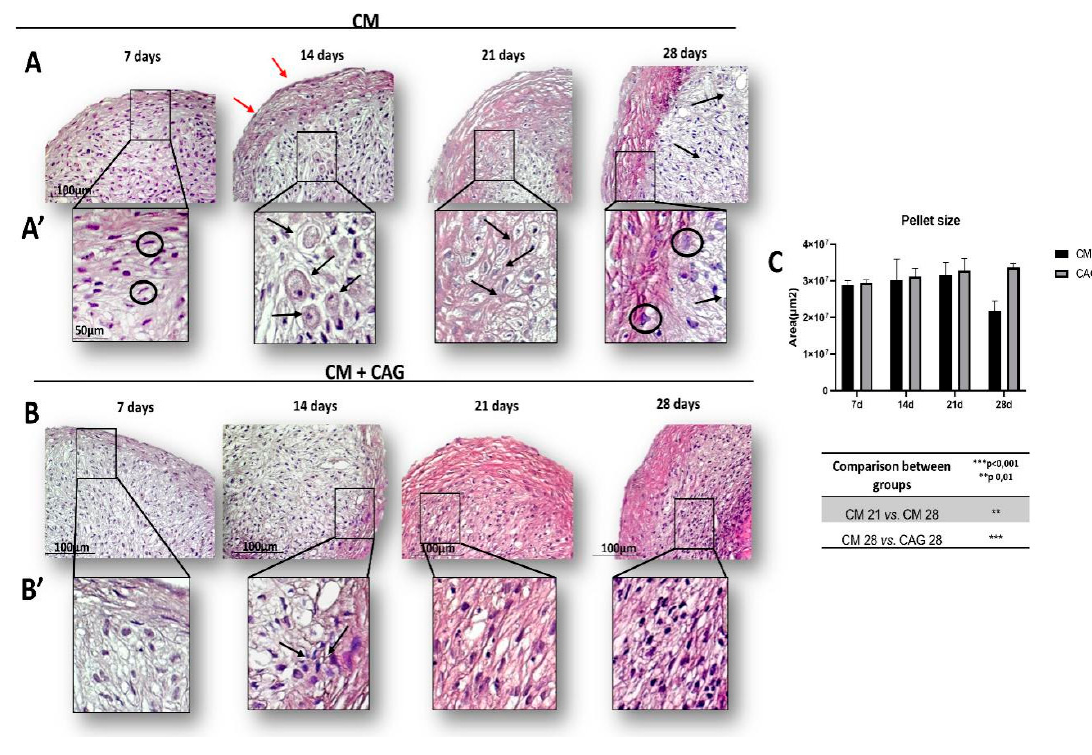
Figure 2. Time-based chondrogenic differentiation of hAMSC pellets, either without ( A ) or with ( B ) the supplementation of CAG (0.1 μ M), evidenced by hematoxylin and eosin (H&E) staining at 7, 14, 21 and 28 days. ( A ) control group (chondrogenic medium: CM); ( B ) CAG-supplemented group (CM + CAG). ( A’ , B’ ) The inserts representing the image magnifications (objective lens, 20×; scale bar: 50 μ m), to evidence the morphology changes observed in a time-dependent manner. In the control group ( A’ ) we observe: at 7 days, fibroblast-like cell shape (black circles), high cell ability to aggregate and form 3D pellets, not much evident extracellular matrix (ECM); at 14 days, some cells show the chondrocyte-like rounded morphology and presence of lacunae (black arrows), and external perichondral capsule formation (red arrows); at 21 days the pellets exhibit the cartilage-like morphology: the cells are organized into columns, lacunae are well-evidenced (black arrows) and ECM production increases; at 28 days the pellets show decreased ECM deposition, especially in the middle zone (black arrows), an evident thickening of the external capsule and cell enlargement (black circles), indicative of hypertrophy. In the CAG-supplemented group ( B’ ), the pellets at 7 and 14 days show a similar morphology when compared to the seven-days control pellets ( A’ ), seemingly with the increased cell proliferation activity (black arrows); at 21 days, the pellets show an increased cell proliferation and ECM deposition activity, evidenced by the intense H&E staining; at 28 days, the cells within the pellets seem to maintain their phenotypic stability, suggested by the enhanced ECM deposition, apparent increase of cell proliferation activity, and poor cellular hypertrophy phenomena. The increased cell proliferation, cellular aggregations, and ECM deposition activity, exhibiting a cartilage tissue-like morphology are observed in the CAG-supplemented group ( B’ ). Objective lens, 10×; scale bar: 100 μ m. ( C ) The pellet-size analysis was assessed by image-analysis software and expressed in μ m 2 . See the Materials and Methods section for details. Results were presented as the mean ± SD. ANOVA was used to evaluate the significance of the results. ** p < 0.01; *** p < 0.001.